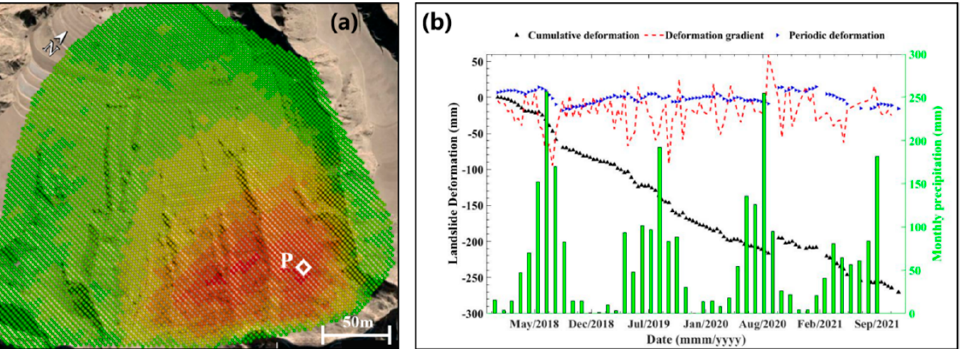
Figure 12. Relationship between deformation time series and monthly precipitation. ( a ) Annual deformation rate map from 11 January 2018 to 15 November 2021; ( b ) the time series of cumulative deformation (in black), deformation gradient (in red), and periodic deformation (in blue) on Point P against monthly precipitation.